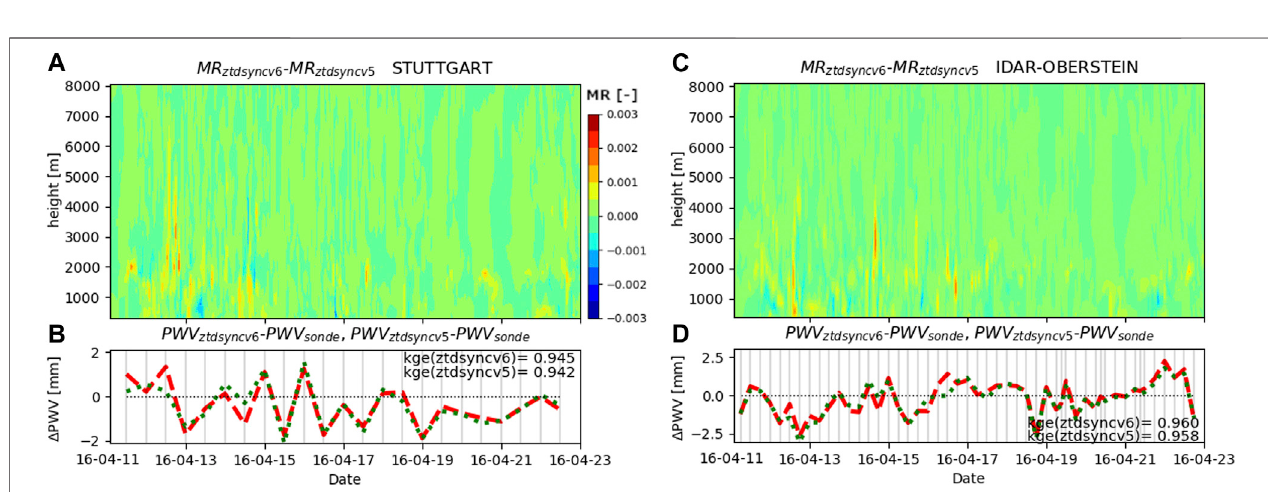
FIGURE9| Difference ofthemixingratio(MR) withheight (A) forthecombined assimilationofZTDand synopticdatabasedonthe cv6 BEoption(red) and the cv5 BE option (green) and bias of corresponding PWV values and radiosonde data for Stuttgart (B) and Idar-Oberstein (C,D) .